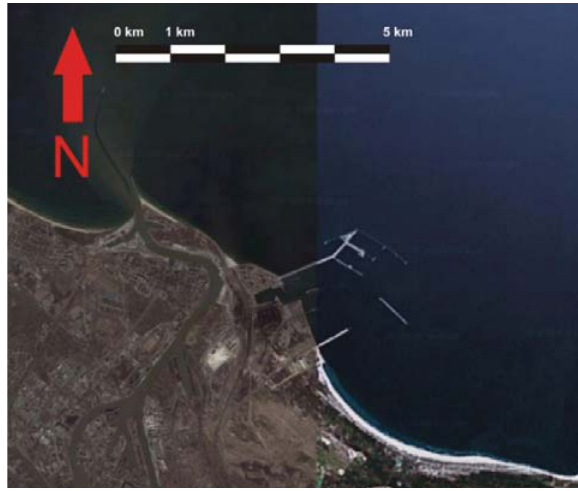
Fig. 3. Th e Port of Gdansk Polnotzny (Poland)